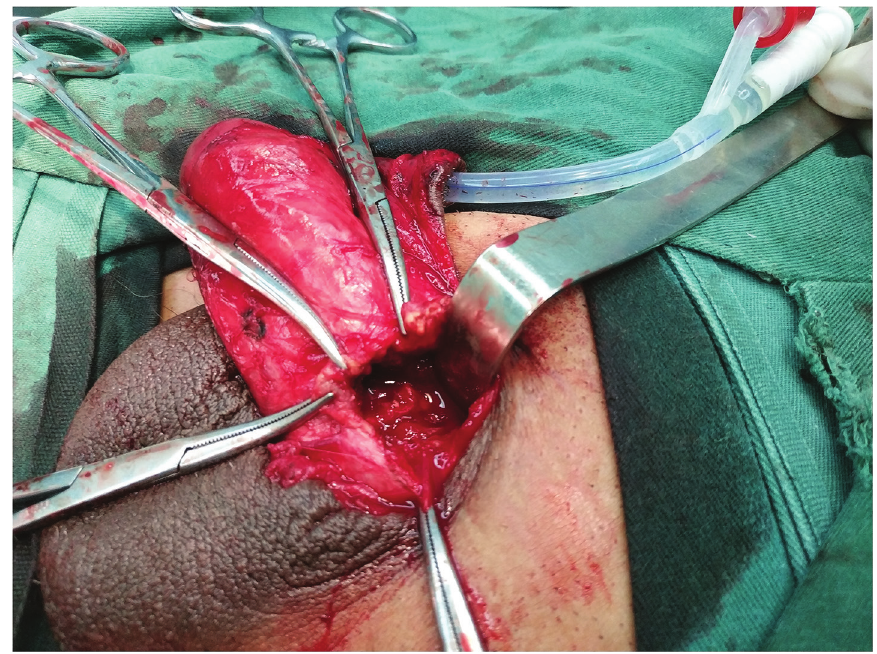
Figure 7. Abscess cavity completely opened during surgery.